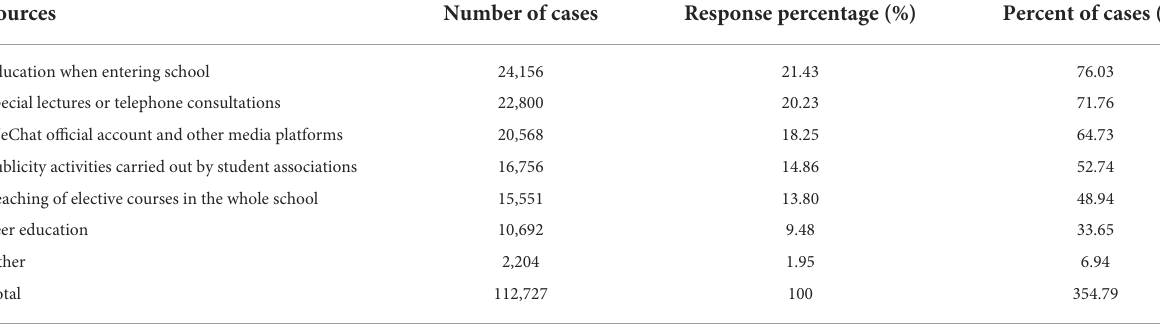
TABLE 13 Main sources of HIV/AIDS knowledge that students were willing to accept ( n = 31,773).